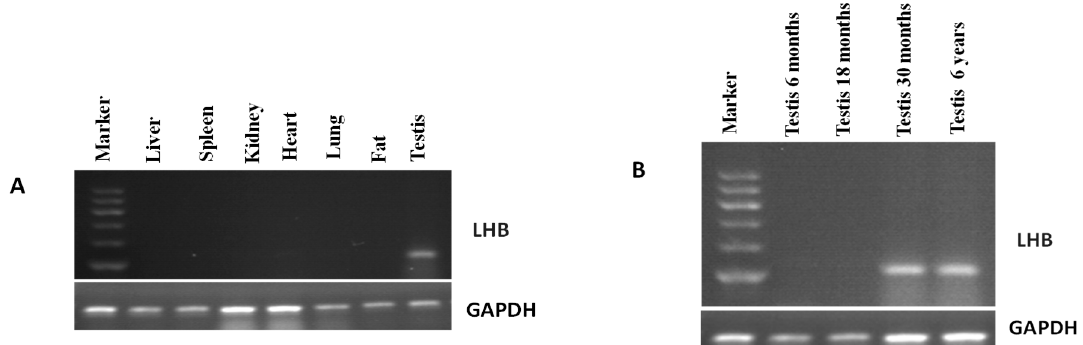
Figure 2. Analysis of the LHB mRNA using semi-quantitative PCR: ( A ) expression profiling from various yak tissues; ( B ) expression profiling at different yak growth stages .